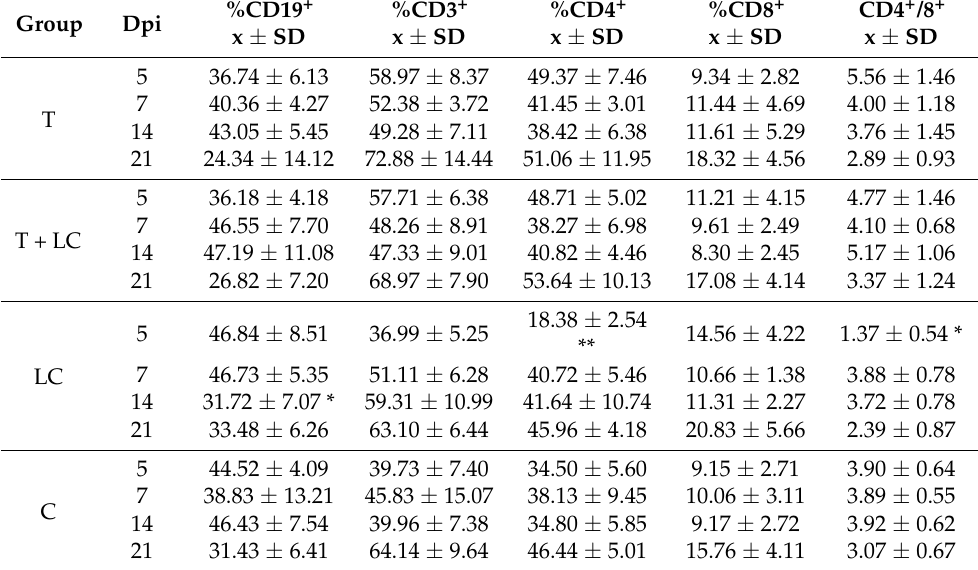
Table 3. The percentage of mesenteric lymph nodes (MLN) B (CD19 + ) and T (CD3 + , CD4 + , CD8 + ) cells in groups of mice: infected with T. spiralis (Group T), infected with T. spiralis and receiving LC (Group T + LC), uninfected with T. spiralis and receiving LC (Group LC) and uninfected mice (control) (Group C). Mean values ( n = 6) and standard deviations are presented. * p < 0.05, ** p < 0.01. Group